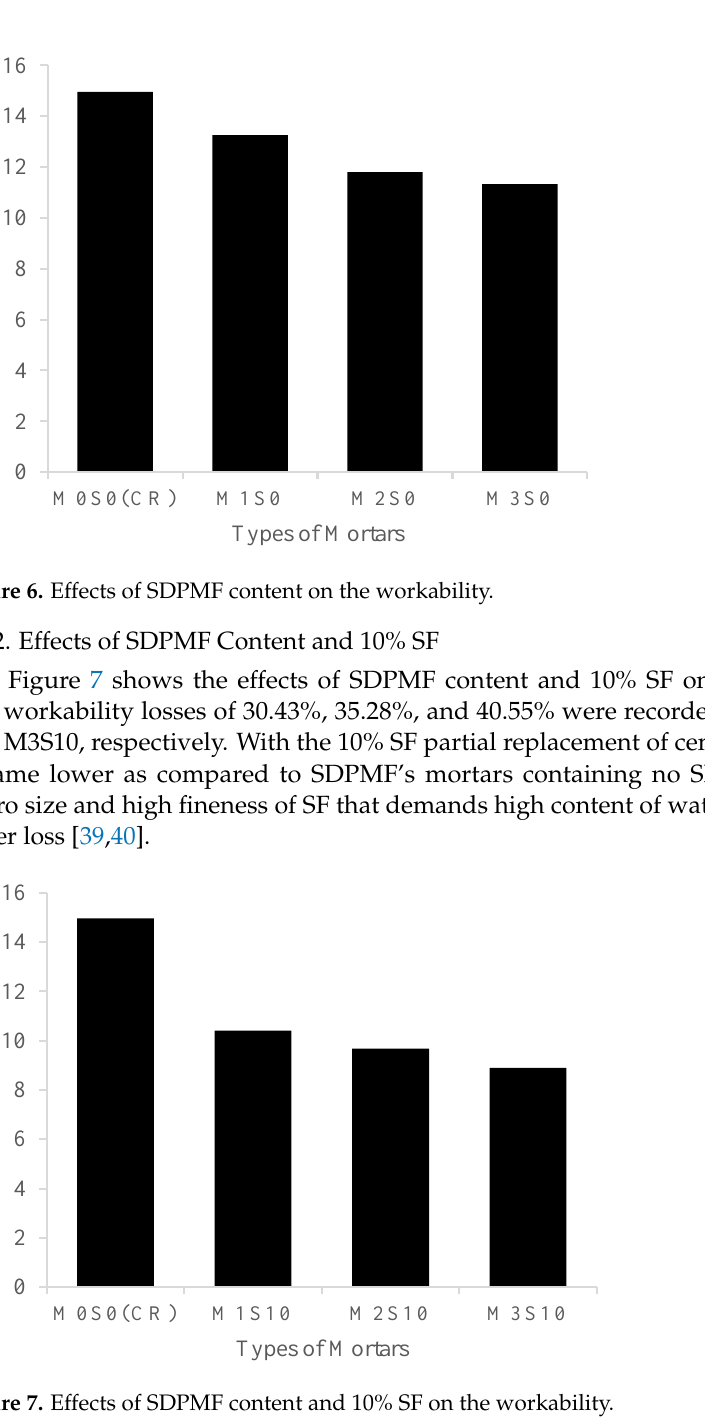
Figure 5. Workability test.